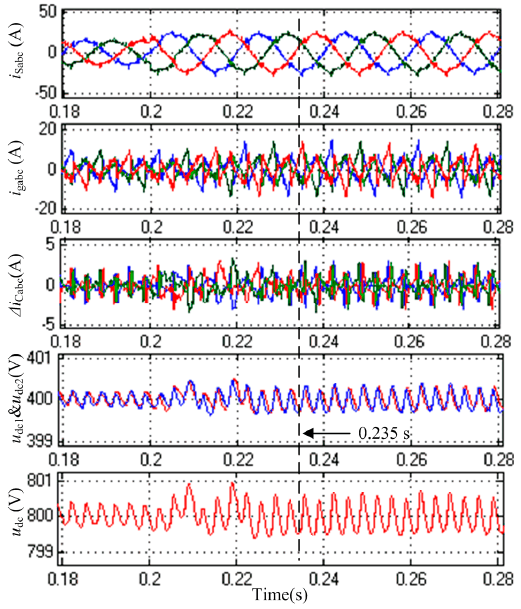
Figure 11. Dynamic response of NPC-SAPF when λ = − 1 × 10 − 3 .